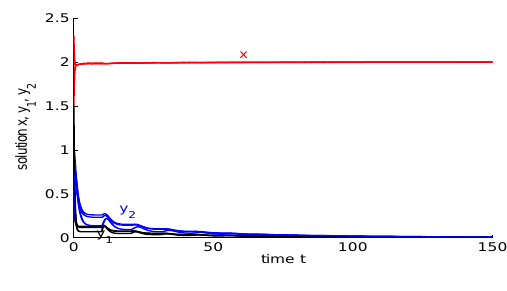
Figure 3: µ = 1 , τ = 10 , E 1 = (2, 0, 0) of system (1.4) is globally asymptotically stable.